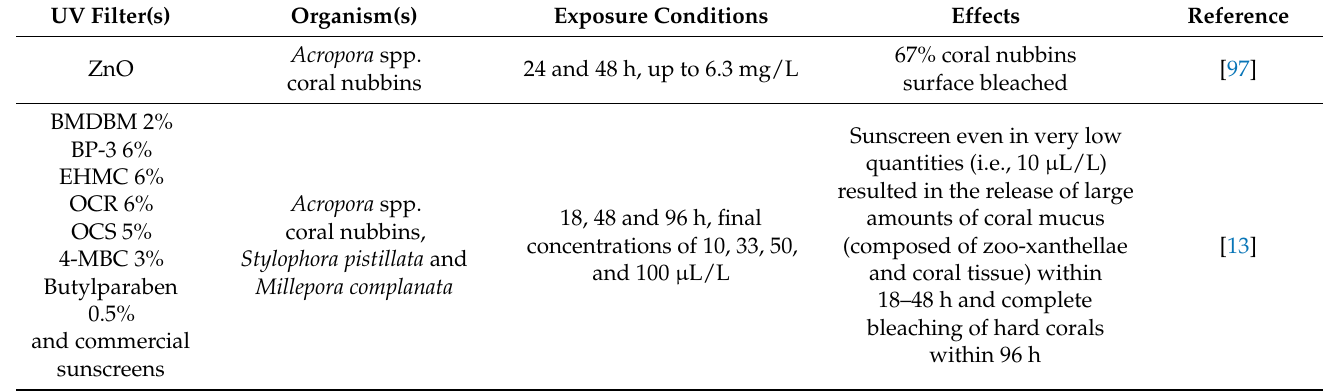
Table 2. Effects of various UV filters on corals and reef